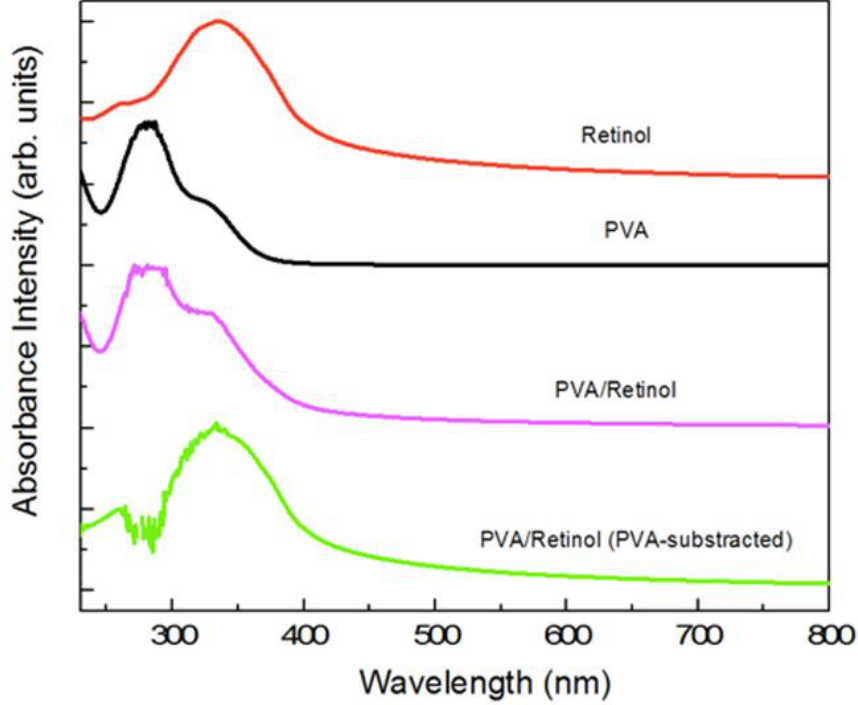
Figure 1. Representative UV-Vis spectra of PVA and retinol-loaded PVA. From top to bottom: i. Retinol aqueous solution containing 0.02 wt.% of retinol (0.2 mg/mL); ii. PVA aqueous solution containing 15 wt.% of PVA (150 mg/mL); iii. PVA/retinol hydrogel containing 150/0.2 mg/mL of PVA and retinol, respectively; and iv. PVA/retinol hydrogel (PVA-substracted) shows the spectrum of PVA/retinol hydrogel containing 150/0.2 mg/mL of PVA and retinol, respectively, by subtracting the PVA as background in which the retinol absorbance peak at 334 nm is clearly observed. All spectra were normalized and shifted along the Y axis for clarity.